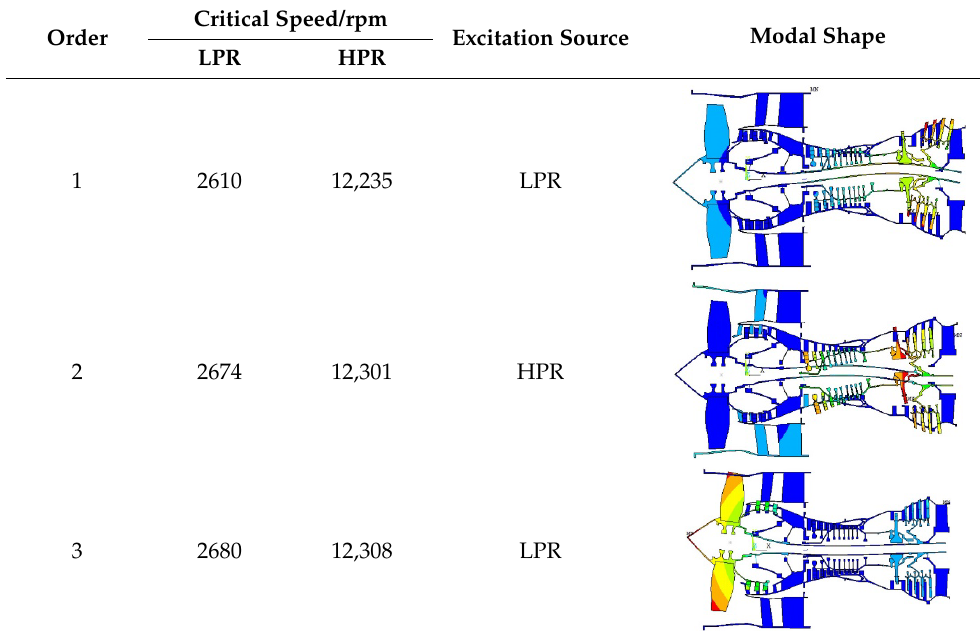
Figure 20. Campbell diagram after optimization. ( a ) Campbell diagram of low-pressure rotor excitation (FP: forward precession, RP: reverse precession); ( b ) Campbell diagram of high-pressure rotor excitation (FP: forward precession). Table 8. The critical speed and mode shape of the whole engine after